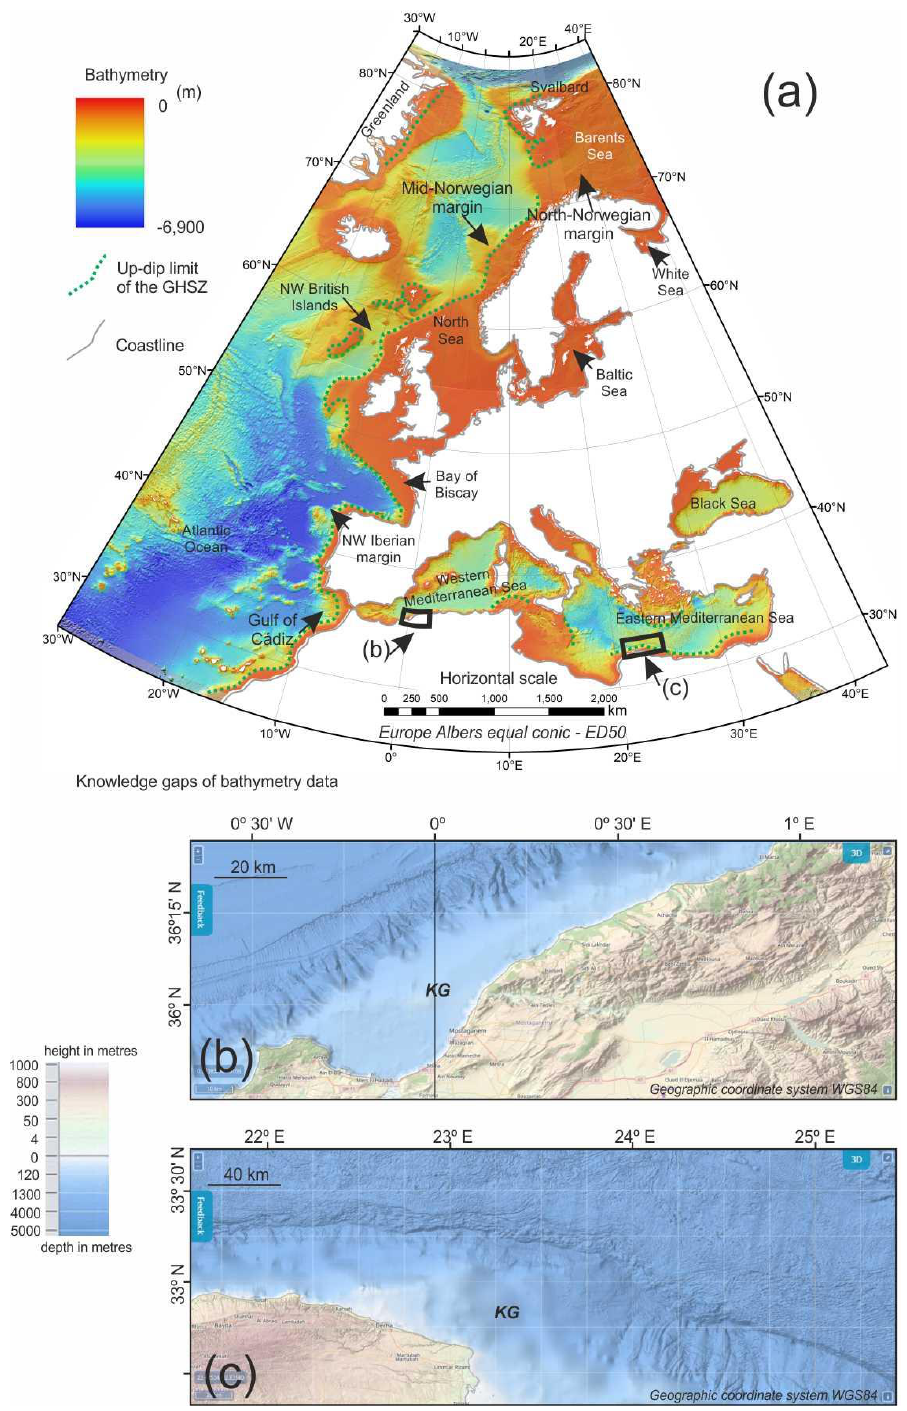
Figure 8. Knowledge gaps of bathymetry data. ( a ) EMODnet Bathymetry mosaic in the study area (cell size ca. 200 × 200 m). ( b ) Detail of knowledge gap on the Algerian margin. ( c ) Detail of knowledge gap on the Libyan margin. Details downloaded from the EMODnet Bathymetry web portal (https://portal.emodnet-bathymetry.eu/; accessed on 1 January